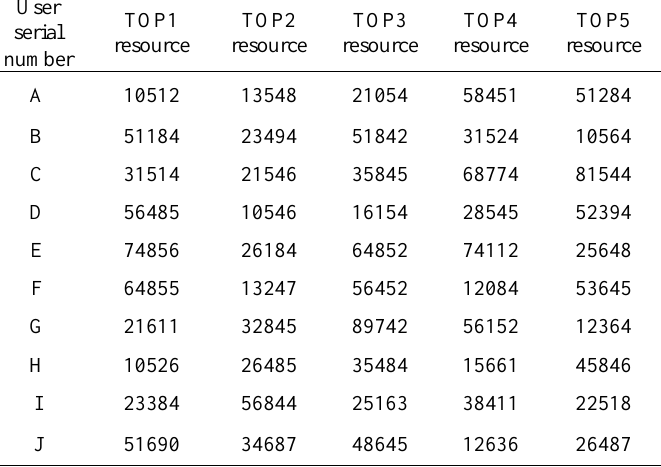
Table 2. Resource matching